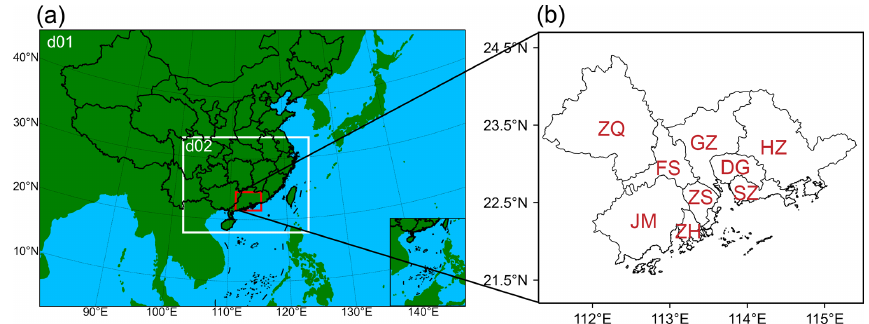
Figure 1. (a) The two nested model domains in the WRF-CMAQ model and (b) the location of the nine main cities in the PRD region.